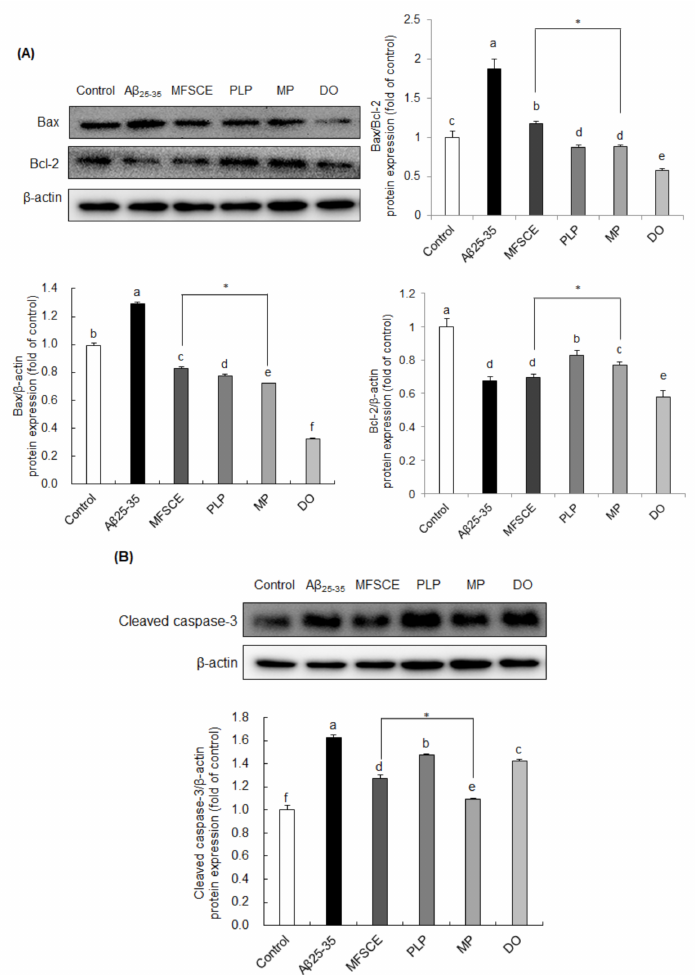
Figure 5. Effect of MFSCE on the neuronal-apoptosis-related protein expression in the brain of A β 25–35 -injected mice. Western blotting and quantitative analysis of ( A ) Bax/Bcl-2 ratio, Bax, and Bcl- 2 and ( B ) cleaved caspase-3 protein expression levels in the brain. Data are expressed as mean ± SD ( n = 3). a–e Means with different letters are significantly different ( p < 0.05) from each group. * β -actin served as the loading control. Asterisk (*) indicates statistically significant differences ( p < 0.05) between MFSCE and MP groups. p < 0.05 vs. MFSCE group. Control group: 0.9% NaCl saline i.c.v. + 0.9% NaCl saline i.p.; A β 25–35 group: A β 25–35 i.c.v. + 0.9% NaCl saline i.p.; MFSCE group: A β 25–35 i.c.v. + MFSCE (100 mg/kg) i.p.; PLP group: A β 25–35 i.c.v. + PLP (1 mg/kg) i.p.; MP group: A β 25–35 i.c.v. + MFSCE (100 mg/kg) and PLP (1 mg/kg) i.p.; DO group (positive control): A β 25–35